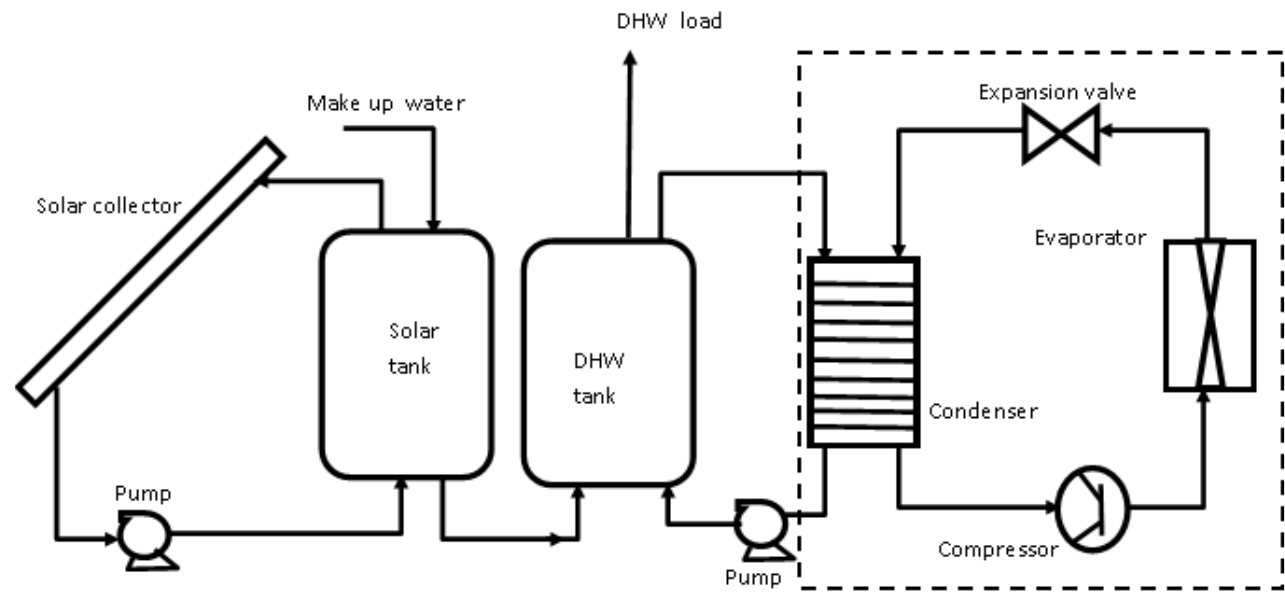
Figure 4. Dual configuration—SAHP water heater.